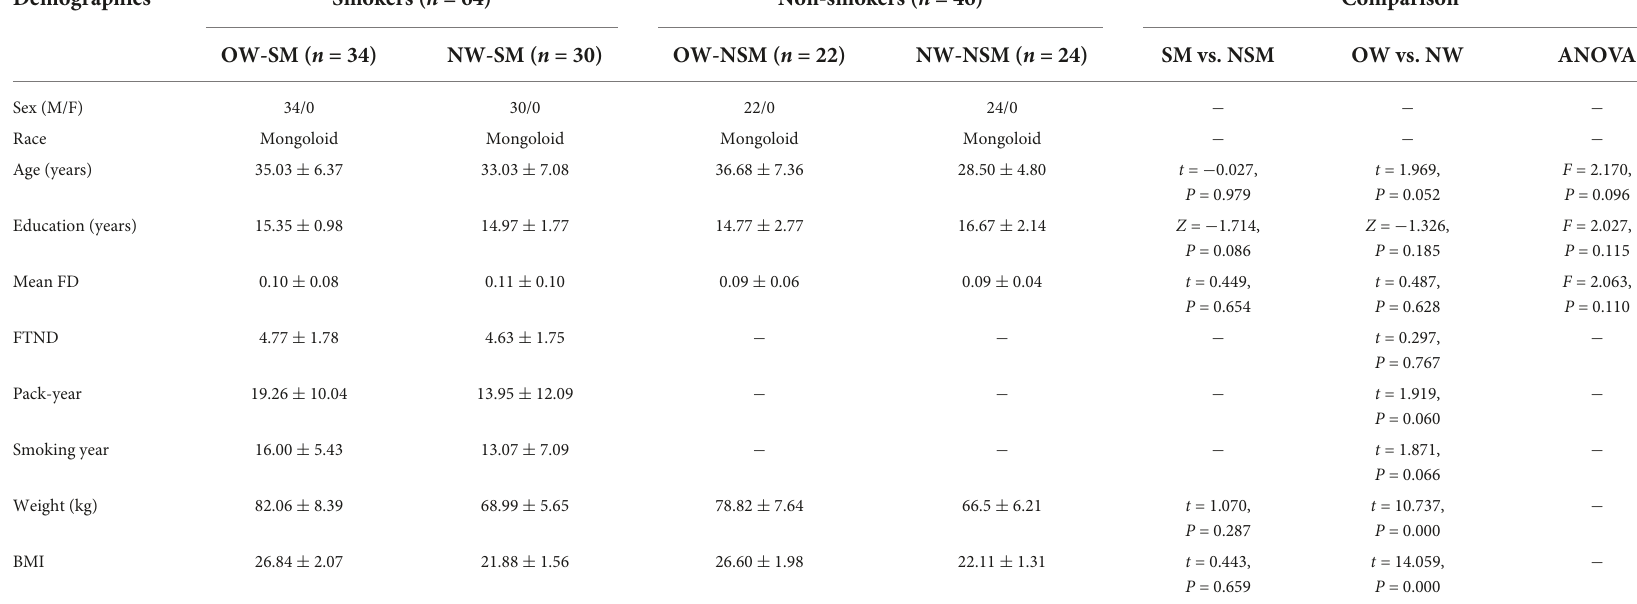
TABLE 1 Demographic and clinical